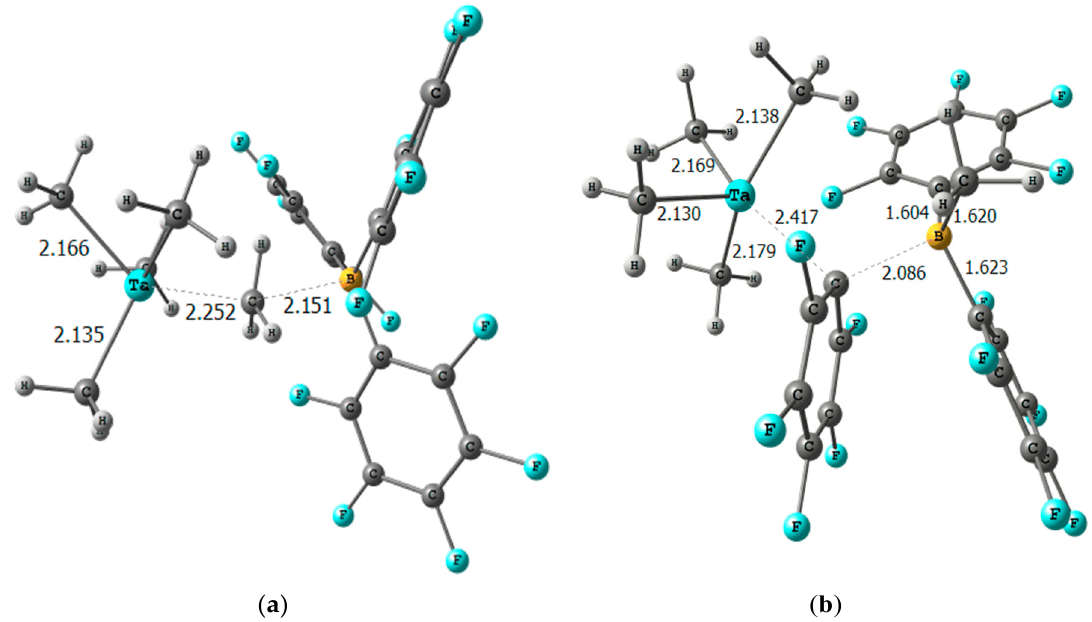
Figure 2. Transition states for ( a ) the demethylation of TaMe 5 by B(C 6 F 5 ) 3 and ( b ) (C 6 F 5 ) − transfer from B(Me)(C 6 F 5 ) 3 − to TaMe 4+ , main distances are shown in Å. Table 1. Gibbs energy values (in kcal/mol) for ( a ) the energy barrier of the transition state of the anion demethylation in the reaction [MMe x → MMe (x − 1)+ + Me − , ( b ) the relative stability of the next demethylated anion MMe (x − 1)+ , ( c ) the intermediate MMe (x − 1) · after the loose of a radical methyl